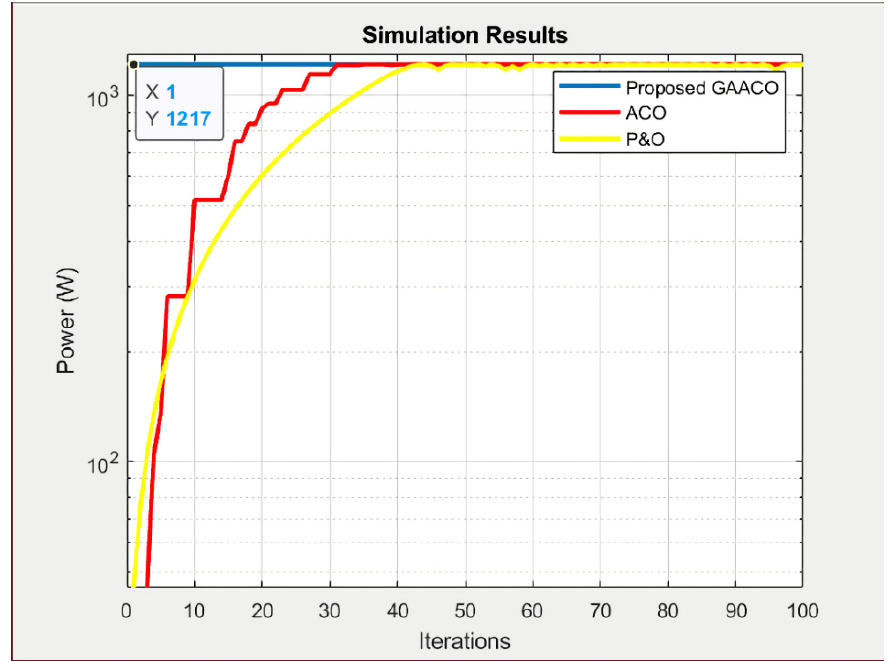
Figure 6. A comparison of simulation of the proposed GA-ACO MPPT with those from the P&O and conventional ACO MPPTs in Case 1.